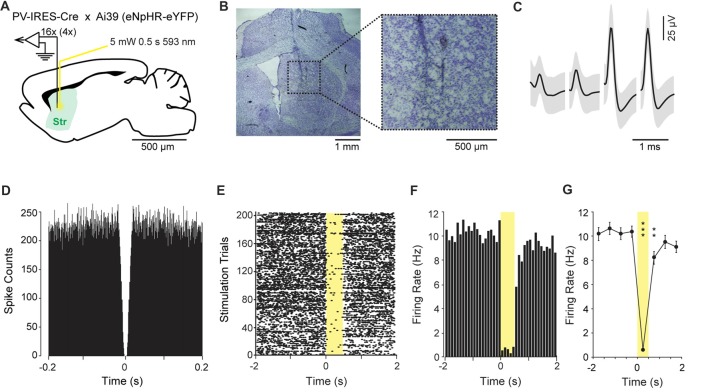
Optogenetic inhibition of parvalbumin (PV)-positive neurons in the striatum. (A) Schematic representation of the recording and light delivery location in the striatum (Str). (B) Histological confirmation showing the position of the tetrodes. (C) Average waveform of one isolated single unit recorded on the four channels of one tetrode. Shading indicates three standard deviations around the mean. (D) Autocorrelogram of the unit shown in (C), confirming that there is no spike during the firing refractory period. (E) Raster plot showing the activity of the unit shown in (C), during ±2 s around the illumination onset. Yellow shading shows the period of light delivery. (F) Peri-stimulus time histogram showing reduction of the firing rate during illumination. (G) Average firing rate during consecutive 500-ms intervals around light delivery. Error bars represent one standard deviation around the mean. **P < 0.01, ***P < 0.001.